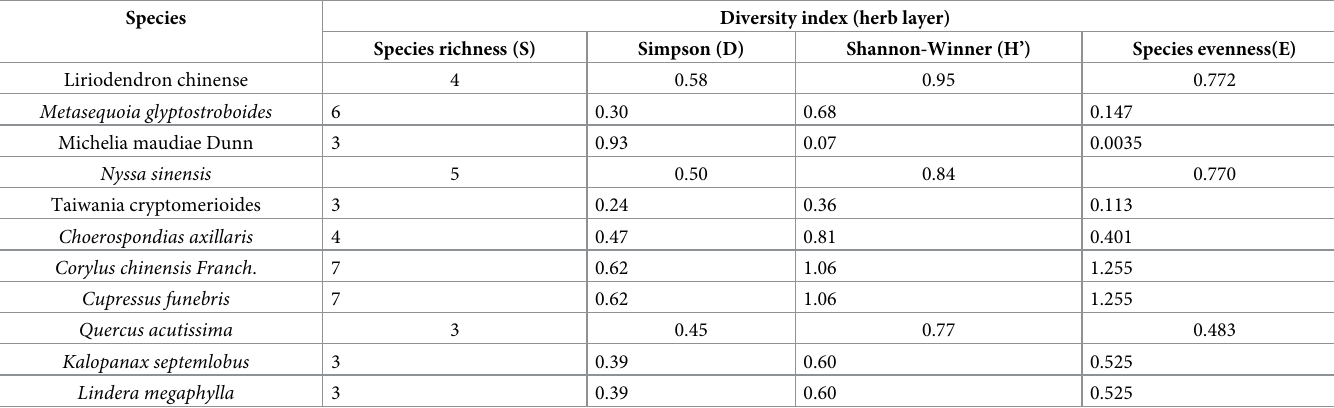
Table 3. Plant diversity indexes of herbs layer of different vegetation types.